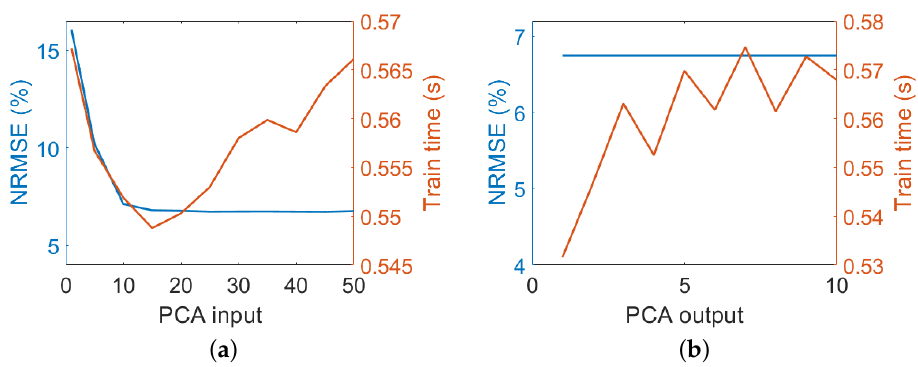
Figure 5. NRMSE (in %) (blue axis) and process time (orange axis) results for the KRR emulator performance assessment varying number of PCs in PCA input conversion (1000 samples, 5 PCA output) ( b ), and PCA output conversion (1000 samples, 20 PCA input) ( a ).